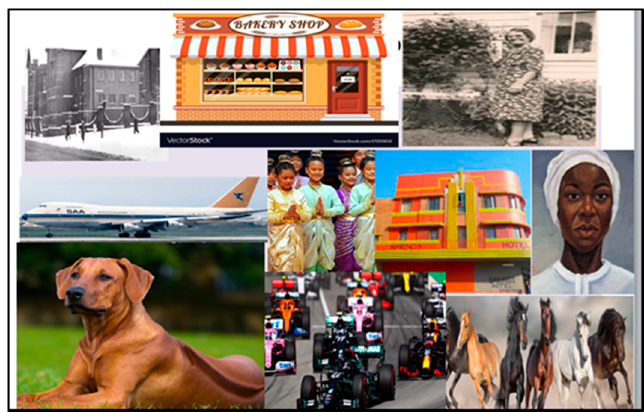
Figure 9. Diana’s timeline for middle childhood.